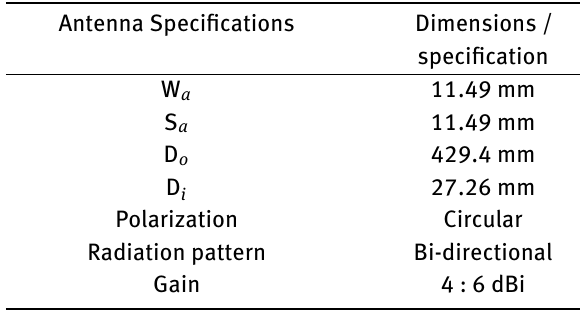
Figure 2: Abdomen model using PAS antenna Table 1: PAS antenna Dimensions and